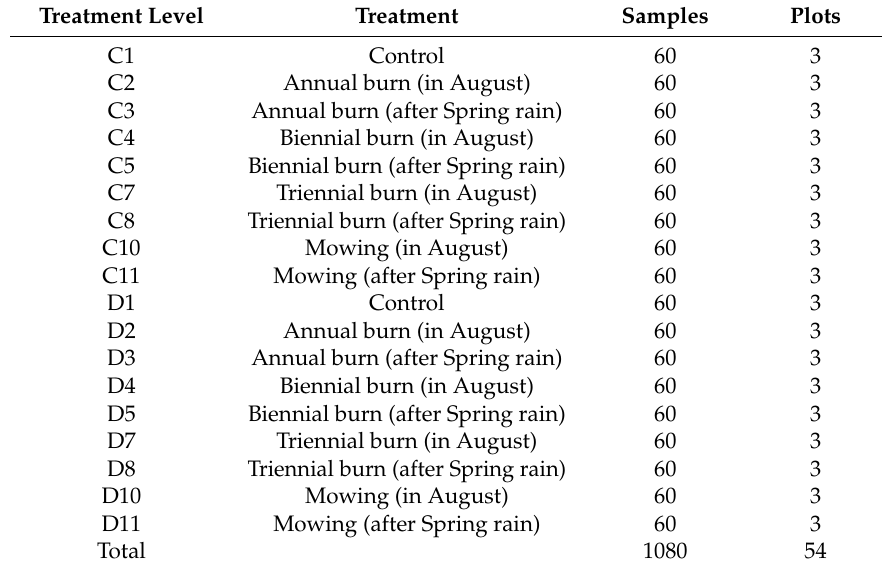
Table 1. Reflectance samples measured on each rangeland management treatment. Treatment Level